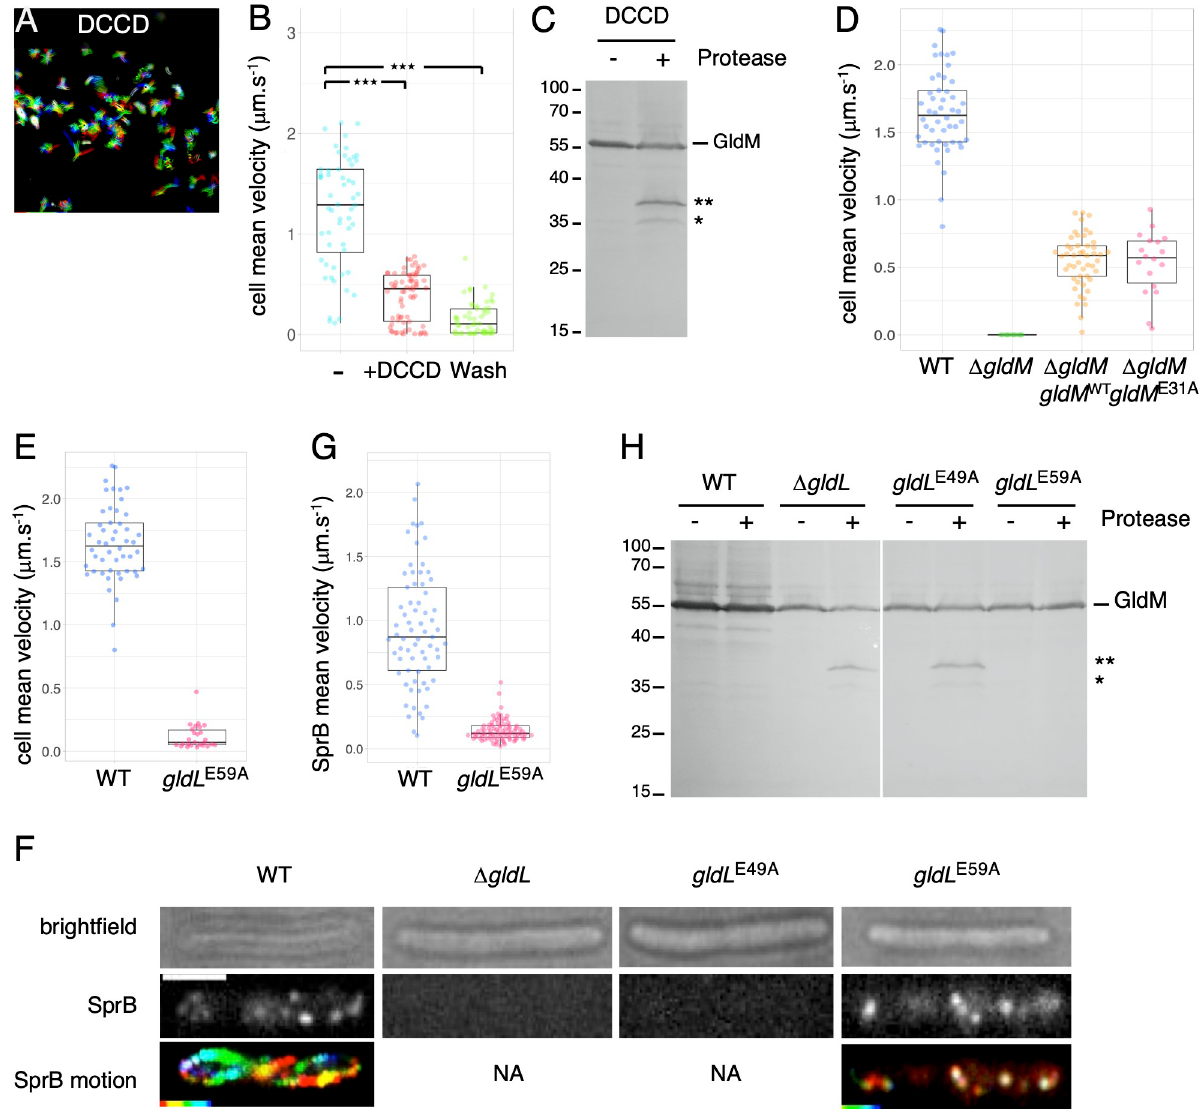
Fig 4. Roles of conserved GldL TMH2 glutamates in T9SS-dependent secretion and dynamics of SprB. (A) The addition of the drug DCCD inhibited cell motility. Rainbow traces of cell motility on glass recorded by phase contrast microscopy over time (2 minutes) in the presence of 10 μ M DCCD. (B) Combined jitter plots/boxplots of mean cell gliding velocity (in μ m.s − 1 ) of n > 50 WT cells before ( − ), during a pulse of 10 μ M DCCD (+DCCD), and after wash with fresh CYE medium (Wash). Statistical significance relative to the nontreated condition ( − ) is indicated above the plots (ns, nonsignificative, ��� , p < 0.001; Wilcoxon t test). Data underlying this figure can be found in S1 Data. (C) Effect of DCCD on GldM protease susceptibility. GldM protease accessibility assay on spheroplasts of WT F . johnsoniae in absence ( − ) or presence (+) of 10 μ M DCCD. (D) GldM conserved glutamate 31 does not play an important role in gliding motility. Combined jitter plots/boxplots of mean cell gliding velocity (in μ m.s − 1 ) of WT cells ( n = 50), and strains expressing ectopically gldM wt ( n = 49) or gldM E31A point mutant ( n = 18) in a Δ gldM mutant background. The Δ gldM mutant has been placed in the graph for relevance but cell velocity has not been measured for that strain because it did not adhere to glass. Data underlying this figure can be found in S1 Data. (E) Combined jitter plots/boxplots of mean cell gliding velocity (in μ m.s − 1 ) of WT cells ( n = 50) and a gldL E59A point mutant ( n = 26). Strains were cultivated in CYE and single-cell gliding was observed on a free glass coverslip by phase contrast microscopy during 2 minutes. Gliding of the Δ gldL mutant and of the gldL E49A point mutant was not measured because cells did not adhere to the glass substratum. Data underlying this figure can be found in S1 Data. (F ) Localization and dynamics of SprB on the cell surface in the WT strain, a Δ gldL mutant, a gldL E49A point mutant, and a gldL E59A point mutant. A representative cell is shown. Strains were cultured in CYE and, after SprB immunolabeling, were sandwiched between an agarose pad and a glass coverslip to significantly limit cell movement and facilitate SprB signal acquisition and analysis. SprB was immunolabeled using a primary serum directed against SprB and Alexa-488 fluorescent secondary antibodies. Fluorescence was recorded with 100-ms intervals for several seconds. The brightfield image (top panel), the first frame (middle panel, in gray levels), and the rainbow trace of SprB motion over time (bottom panel, not available for the Δ gldL mutant and the gldL E49A point mutant) are shown. Scale bar, 2 μ m. (G) Combined jitter plots/boxplots of mean displacement velocity (in μ m.s − 1 ) of SprB in WT cells ( n = 69) and a gldL E59A point mutant